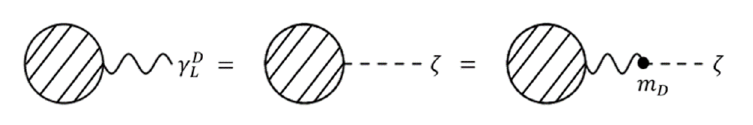
Figure 6 . A pictorial representation of the suppression of matrix elements containing longitudinal dark photons in the low mass/high energy limit. The first equality is the Goldstone boson equiva- lence theorem stating that in the low mass/high energy limit any matrix element with an external longitudinal photon is equal to the same matrix element with the longitudinal dark photon replaced with the Goldstone boson. The second equality makes use of the 2 point Goldstone bosons-dark photon interaction term that results from leaving unitarity gauge. This coupling scales as m D which gives the desired